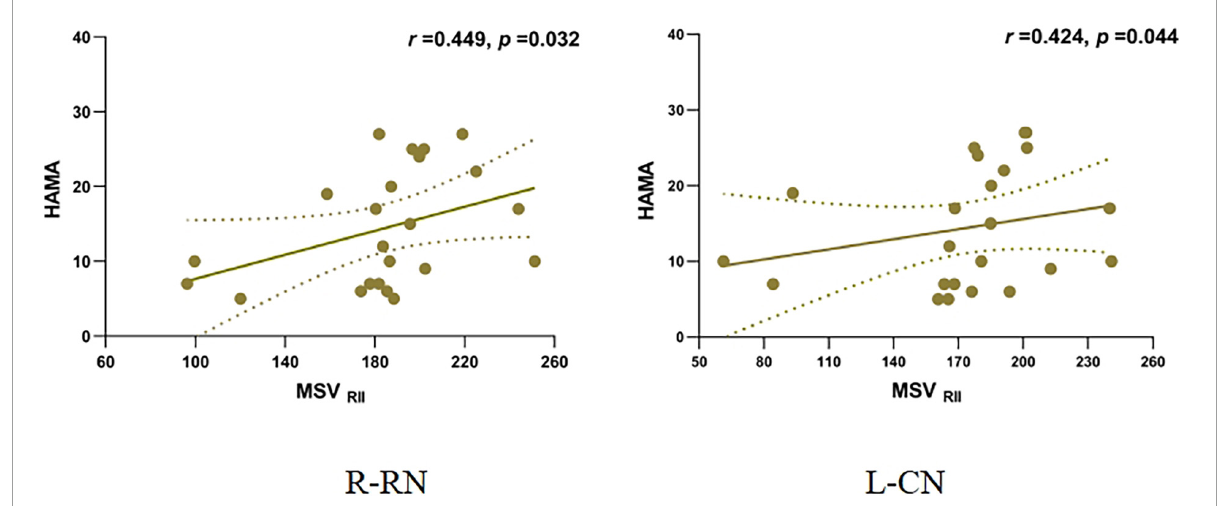
FIGURE4 Correlation of MSVRII and HAMA scores in PDDM Group. Positive correlation between MSV RII of R-RN, L-CN and HAMA score in PDDM group. MSV RII , MSV of the high iron region; PDDM, PD with T2DM; R-CN, right-caudate nucleus; L-CN, left-caudate nucleus; HAMA, Hamilton anxiety scale.